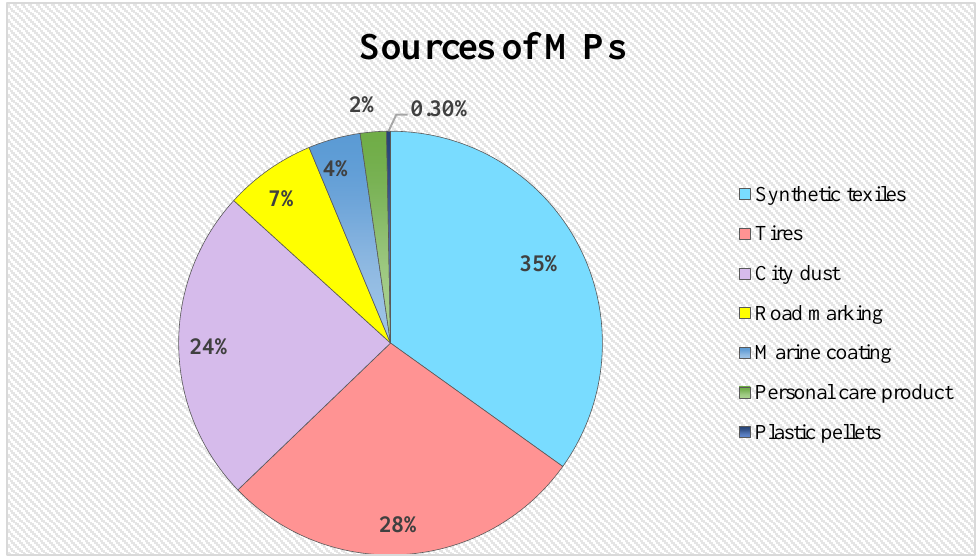
Figure 1. Potential sources of microplastics to contaminate environments (Source: International Union for Conservation of Nature, 2017).